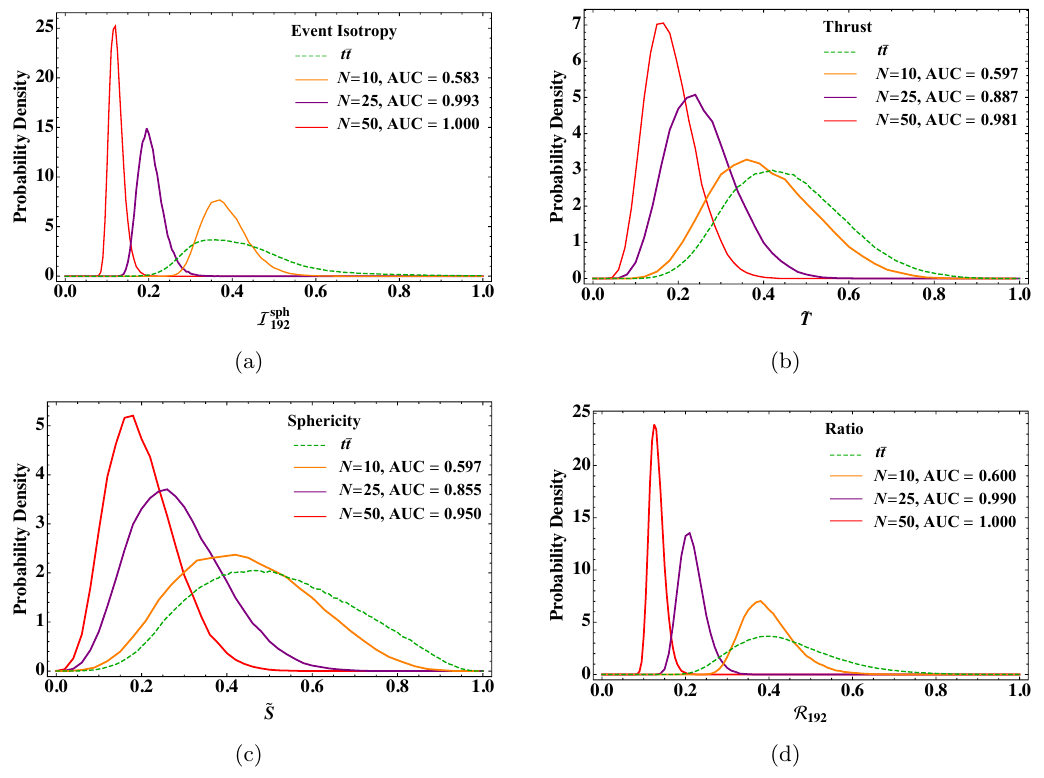
Figure 9 . The same as (cid:12)gure 8, but now compared to the t (cid:22) t background. For su(cid:14)ciently large N , event isotropy is the most e(cid:11)ective